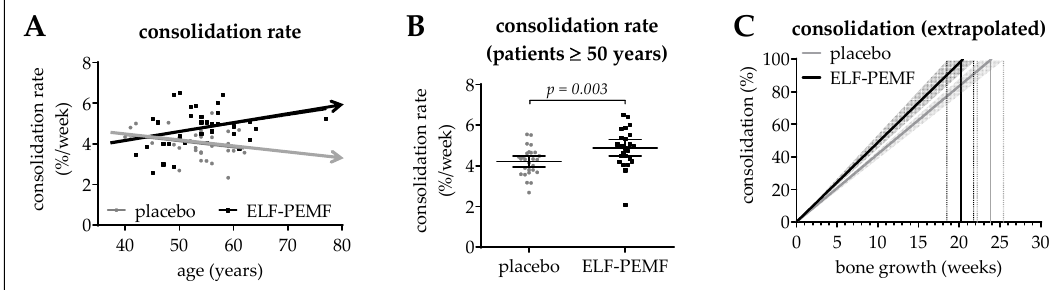
Figure 6. Effect of the patients’ age on the osseous consolidation. ( A ) Correlation between the osseous consolidation rate and the patients’ age. Trend-lines on the X/Y-diagram cross at an age of ~52 a. ( B ) Consolidation rate in patients ≥ 50 a (placebo: N = 27; ELF-PEMF: N = 24). Data are represented as scatter diagram (mean ± 95% CI). Two-tailed Mann–Whitney U -test was used to determine the p -value. ( C ) Extrapolation of the resulting mean (line) ± SEM (surrounding area) consolidation rates of the ELF-PEMF and placebo group. Table 3. Pre-surgical age, sex, wedge height, body mass index (BMI), comorbidities, and nutritional status (NRS) of the patients ≥50 years in our study cohort. Placebo ELF-PEMF p -Value